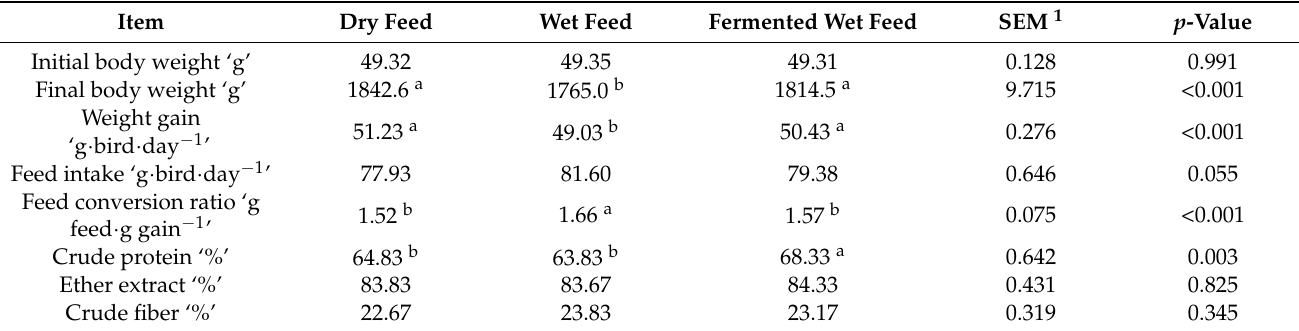
Table 3. Effect of dry, wet and fermented wet feeds on growth performance and digestibility of broiler chickens at 35 days of